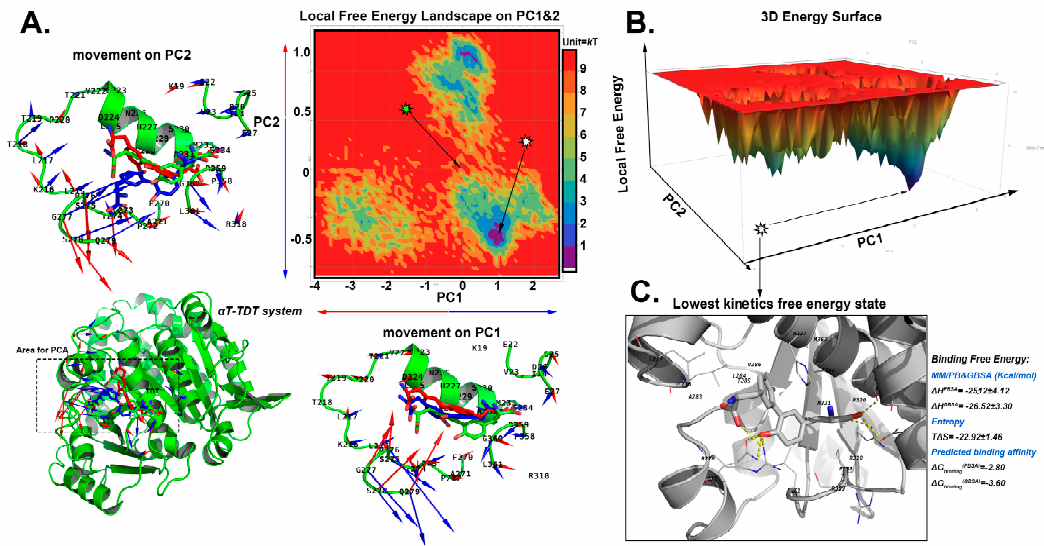
Figure 6. The search for the lowest free energy poses in α T-TDT MD system by local free energy landscape (LFEL) and MM/GB and PBSA calculations. ( A ) The 2D LFEL heat map. The green star shows the docked conformation with the coordinate (0, 0), and is viewed as a reference structure. The highest local free energy was defined as 10 kT, which can barely be sampled from all the conformational space. The bottom left shows the areas for which PCA calculations were carried out. The docked pose is in green. The movements on PC1 and 2 vectors from the production phase simulations are shown as a porcupine plot alongside with the axis. The scales of arrows are proportional to the scale of movements observed along each PC. The movements towards the positive direction of PC are in blue, and that of negative direction are in red. TDT are in sticks; blue and red sticks represent the minimum and maximum conformations observed by the PC vectors, and surrounding residues are shown as cartoon. The docked pose is coloured in green. ( B ) The converted 3D surface of FEL with the same colour code as shown in panel A. ( C ) The collected state with lowest kinetic free energy. The protein is in white cartoon, TDT are shown by sticks, and the nearby residues are shown as white lines. The hydrogen bonds are indicated by yellow dashes. The collected conformation and the nearby 50 frames were used for calculating the binding free energy, which are displayed nearby panel C.